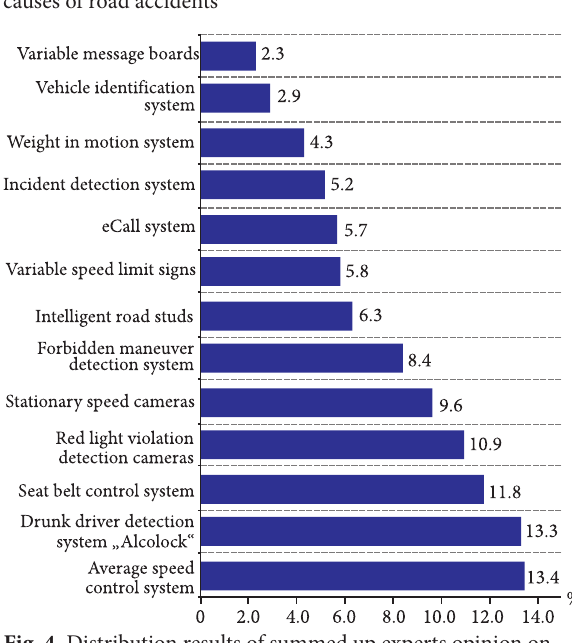
Fig. 4. Distribution results of summed up experts opinion on